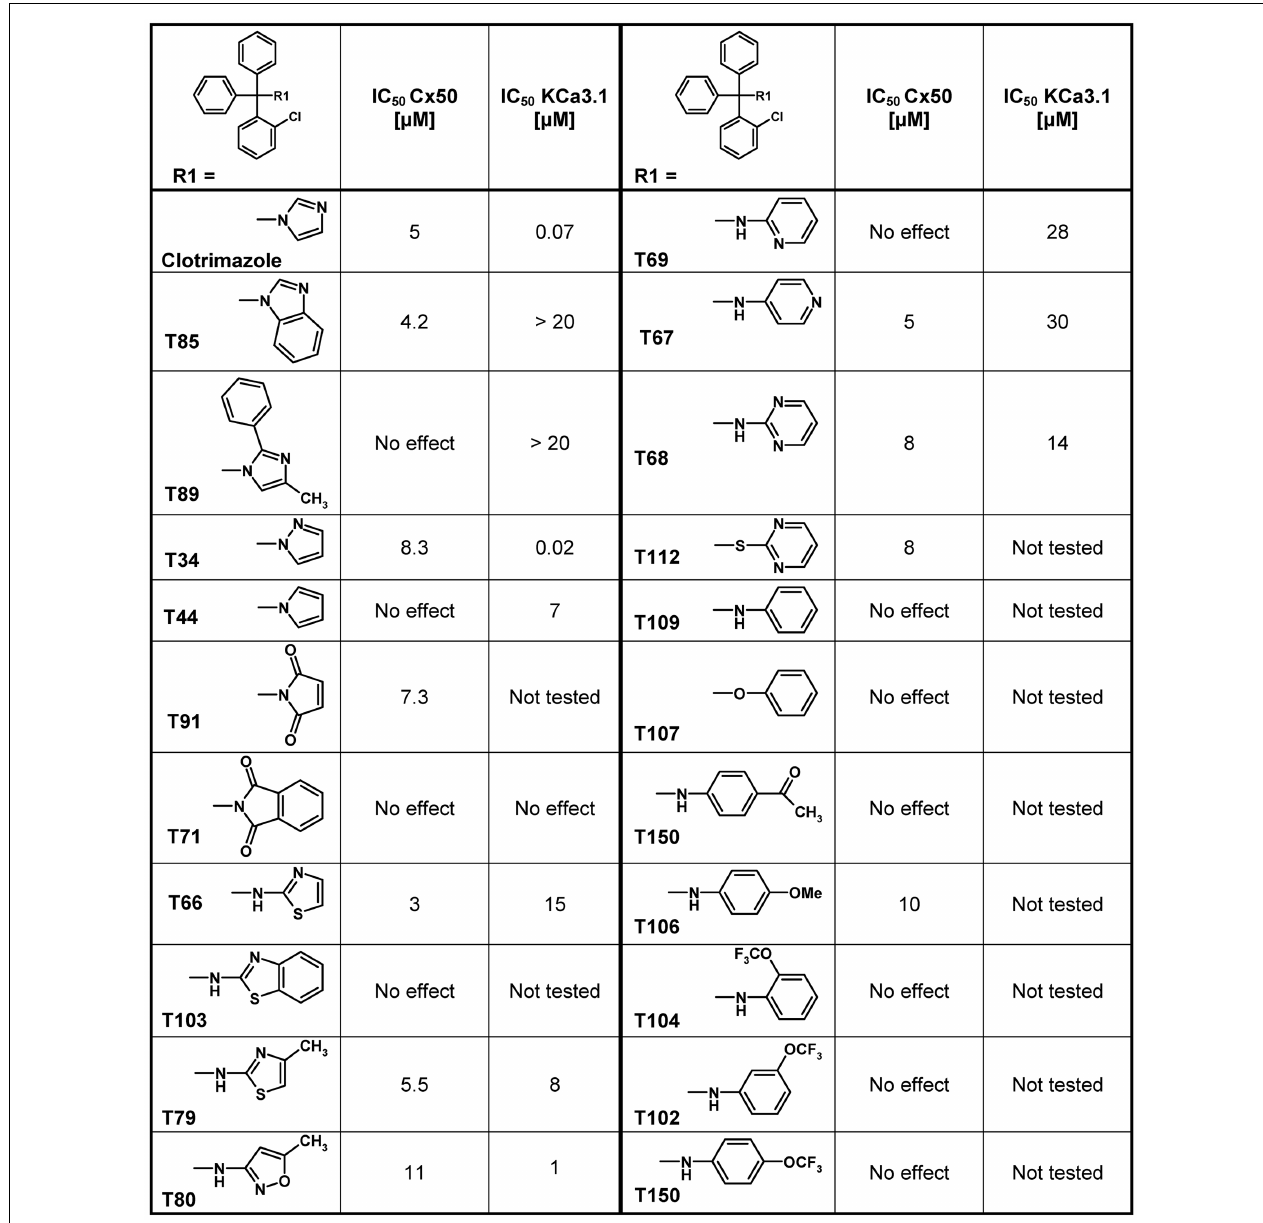
FIGURE 4 |Table showing the structures and IC 50 values for Cx50 and KCa3.1 inhibition of heterocyclic substituted triarylmethanes. Concentrations of triarylmethanes that caused a half-maximal inhibition (IC 50 ) values were obtained by fitting the data to the Hill equation, as described in